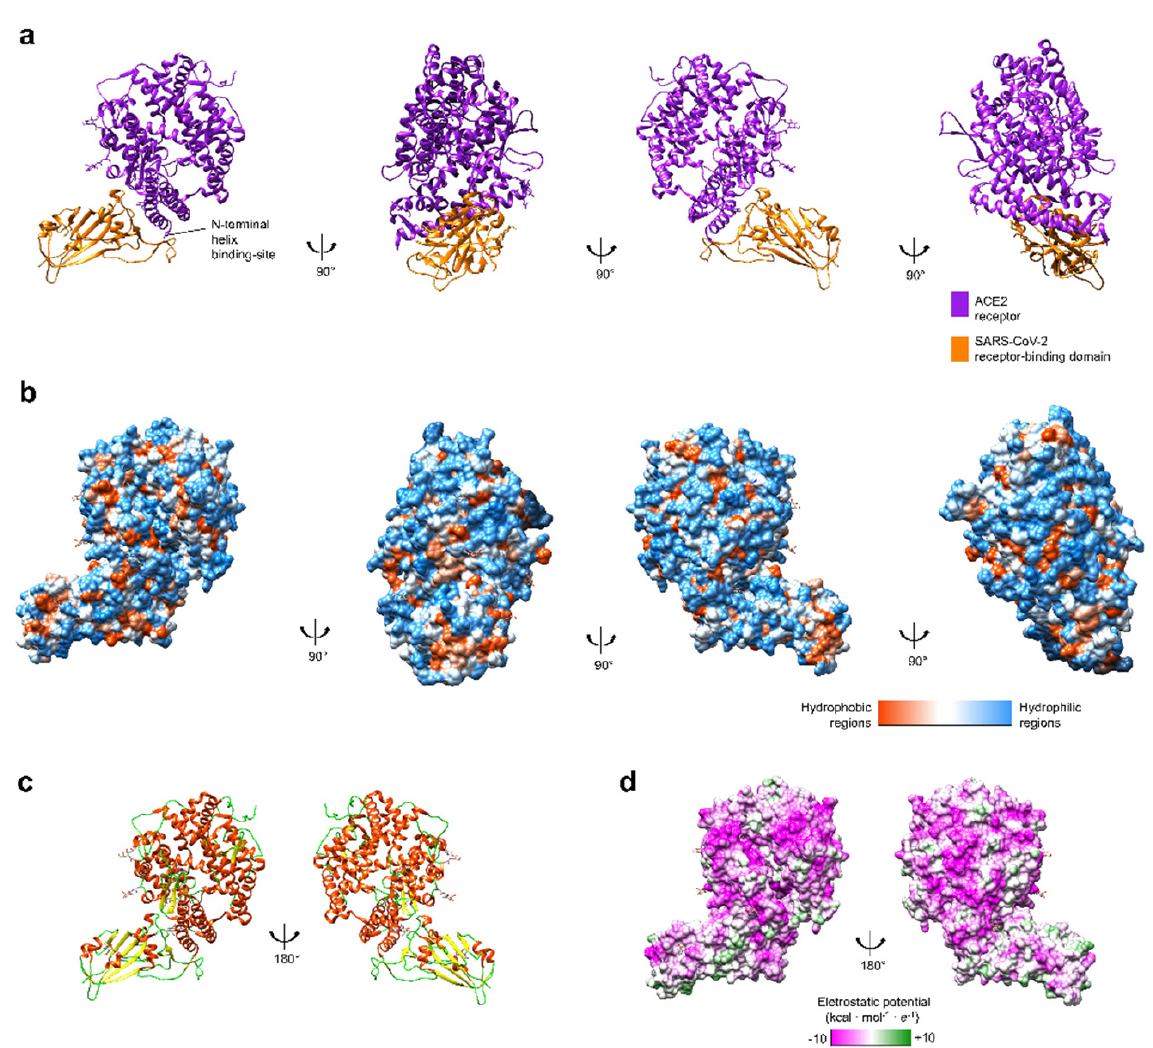
Figure 1. ( a ) Tridimensional structures of spike (S)-protein and ACE2 receptor structure (UniProt structure identifier 6M0J [19]). ( b ) Hydrophobicity surface colored following the Hessa and von Heijne hydropathic scale thresholds (dark orange most hydrophobic; white 0; aquamarine most hydrophilic) as described by Hessa et al. [23]. ( c ) The secondary structure is colored in red (helix), light green (random coil), and yellow (strand). ( d ) Electrostatic surface colored according to Coulombic electrostatic potential, e = 4r, thresholds ± 5 kcal · mol − 1 · e − 1 at 298 K. Molecular graphics and analyses performed using the UCSF Chimera package software